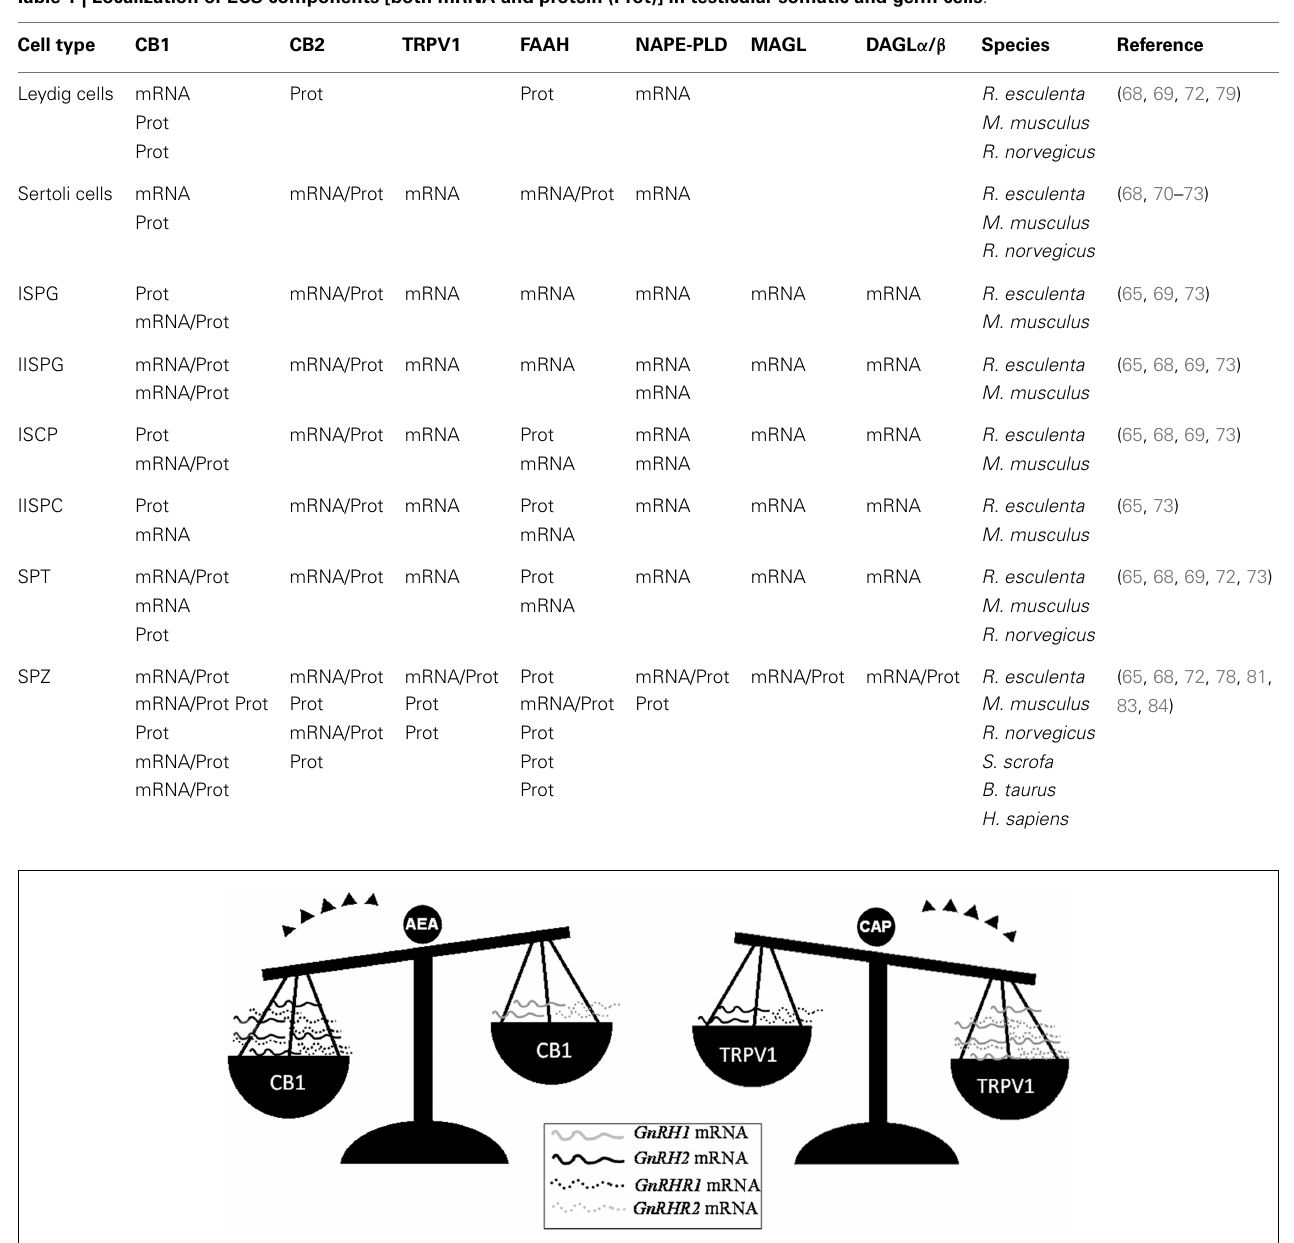
FIGURE 1 | Differential expression of GnRH system components after in vitro incubation of frog testis collected in post-reproductive periods withAEA or capsaicin (CAP), a selective agonist ofTRPV1 receptor . Since